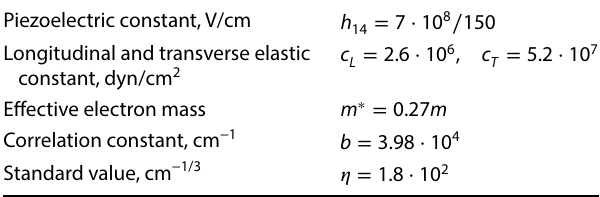
Table 1 Initial parameters of InGaN/AlGaN/GaN